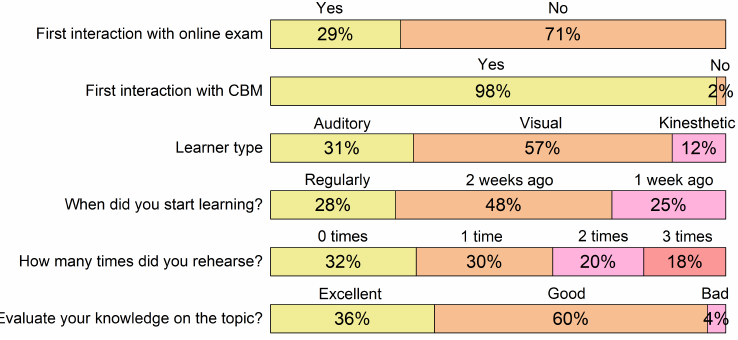
Figure 1. Students’ responses to the questionnaire before the CBM exam ( n = 49). The labels on the left represent the question or a series of questions that were given in the questionnaire. The text above the stacked bars represents the possible answers, while the width of the bar represents the portion of students who selected that answer. The data for Learner type questions has been analysed and only the determined proportions for each learner type are